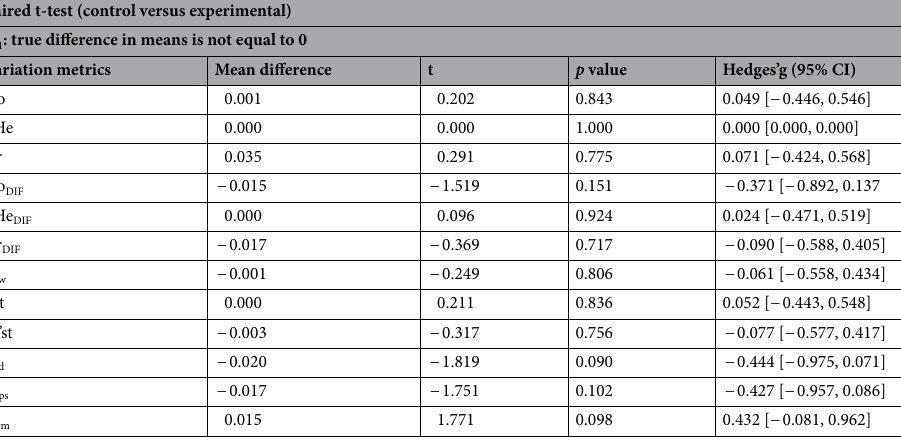
Table 4. Summary statistics and standardized effect size (Hedges’g) for paired t-test between control and experimental plots (controls are set as reference group). Response variables are: observed heterozygosity (Ho), unbiased expected heterozygosity (uHe), allelic richness (Ar) and their homologous between sides within plots computations ( DIF ), genetic variation within plots (σ bw ) genetic differentiation metrics (Fst and G”st) and partial mantel r (r Gd , r Dps , r Lrm ) as a measure of genetic dissimilarities/similarities within plots.